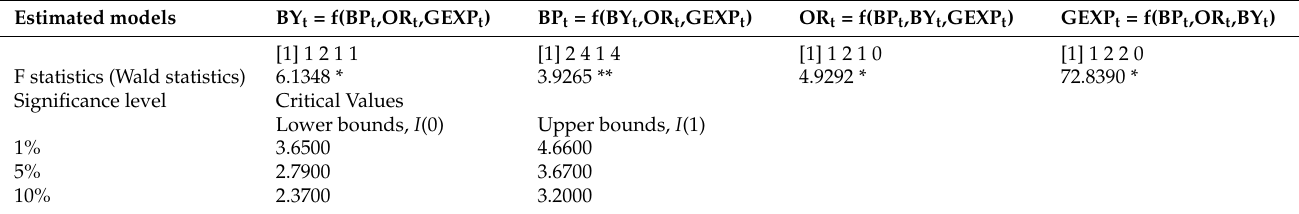
Table 3. Bounds F-test (Wald) for no cointegration with restricted intercept and no trend. Estimated models